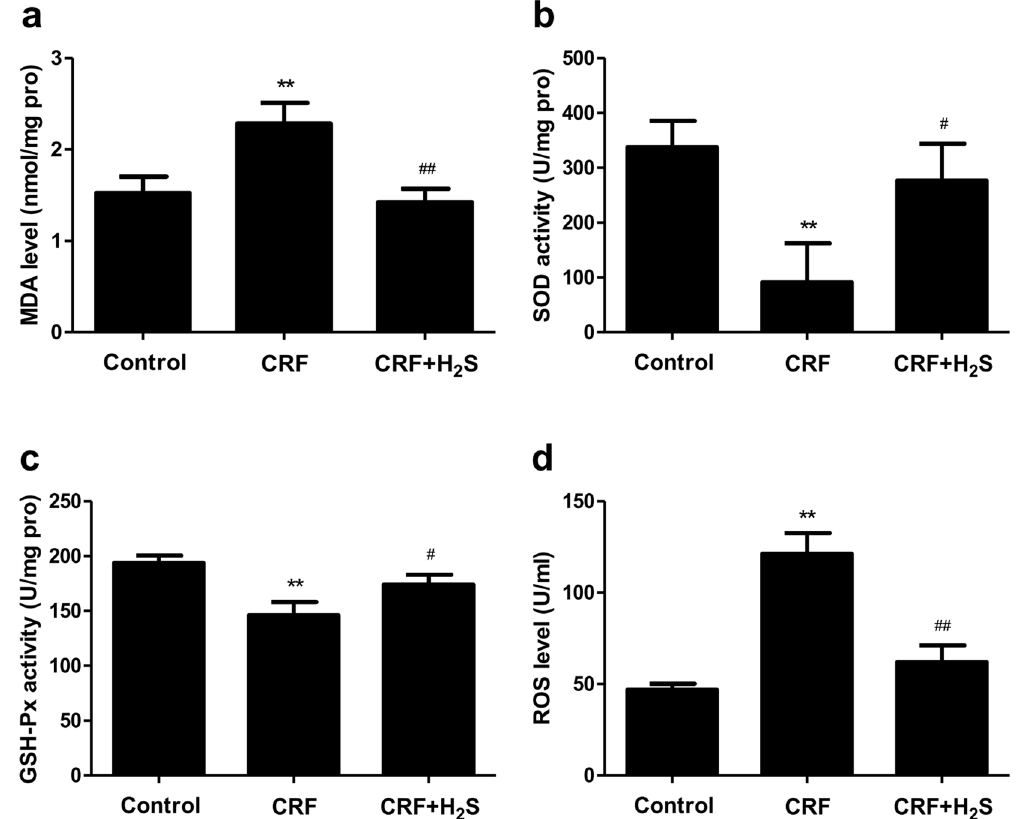
Figure 7. Effects of H 2 S on the MDA level, SOD and GSH-Px activities, and the ROS generation in the kidney of CRF rats. ( a ) MDA level. ( b ) SOD activity. ( c ) GSH-Px activity. ( d ) ROS level. Values were presented as mean ± SEM (n = 8); * P < 0.05, ** P < 0.01 compared with the control group; # P < 0.05, ## P < 0.01 compared with the CRF